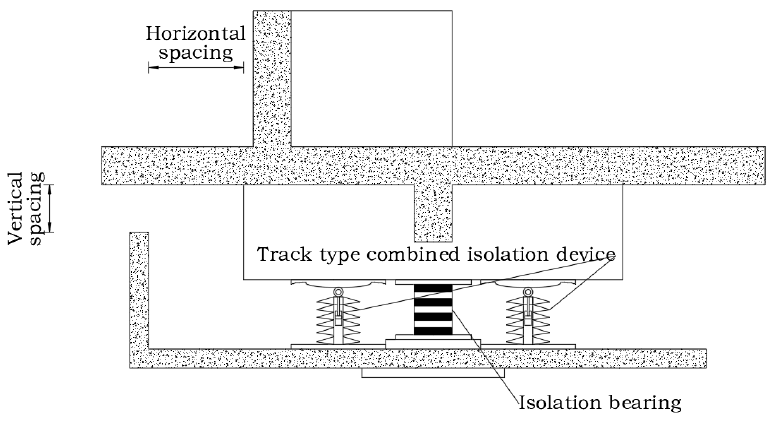
Figure 13. Schematic diagram of variable-stiffness vibration isolation device.